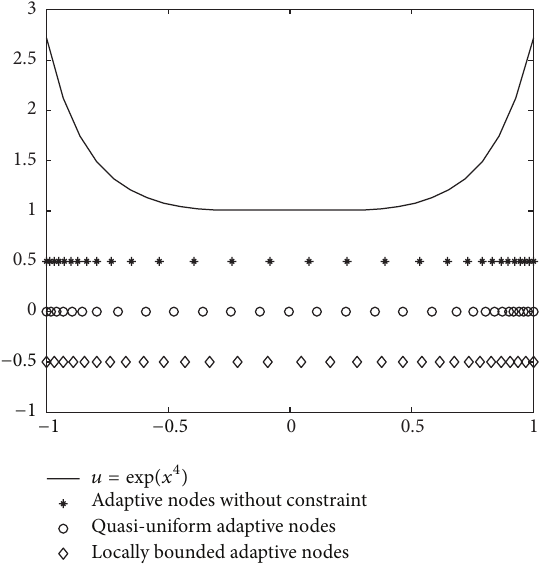
Figure 1: The nodes produced with quasi-uniform and locally bounded